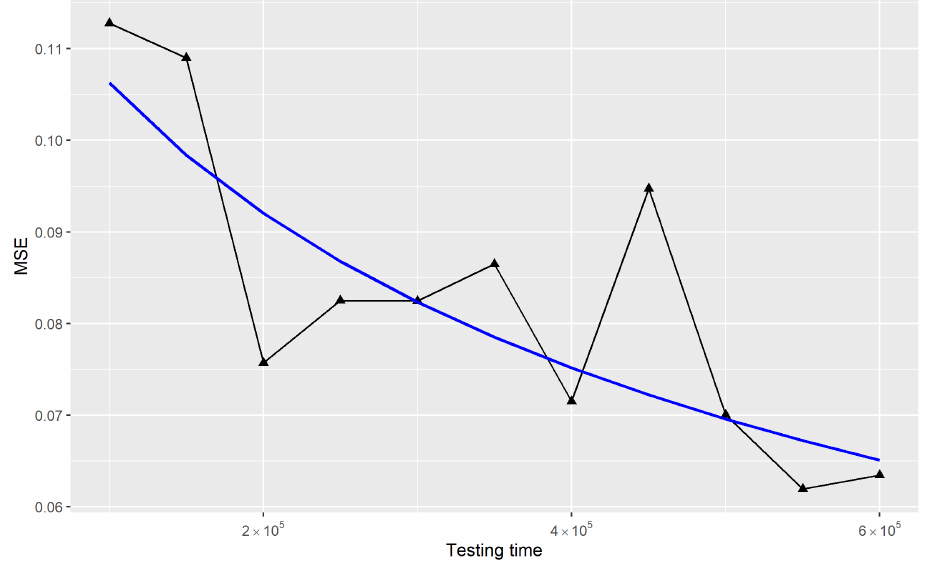
Figure 3. The relationship between mean square error (MSE) and testing time. The blue curve is the trend line fitted by the formula y = 1 √ a + bx